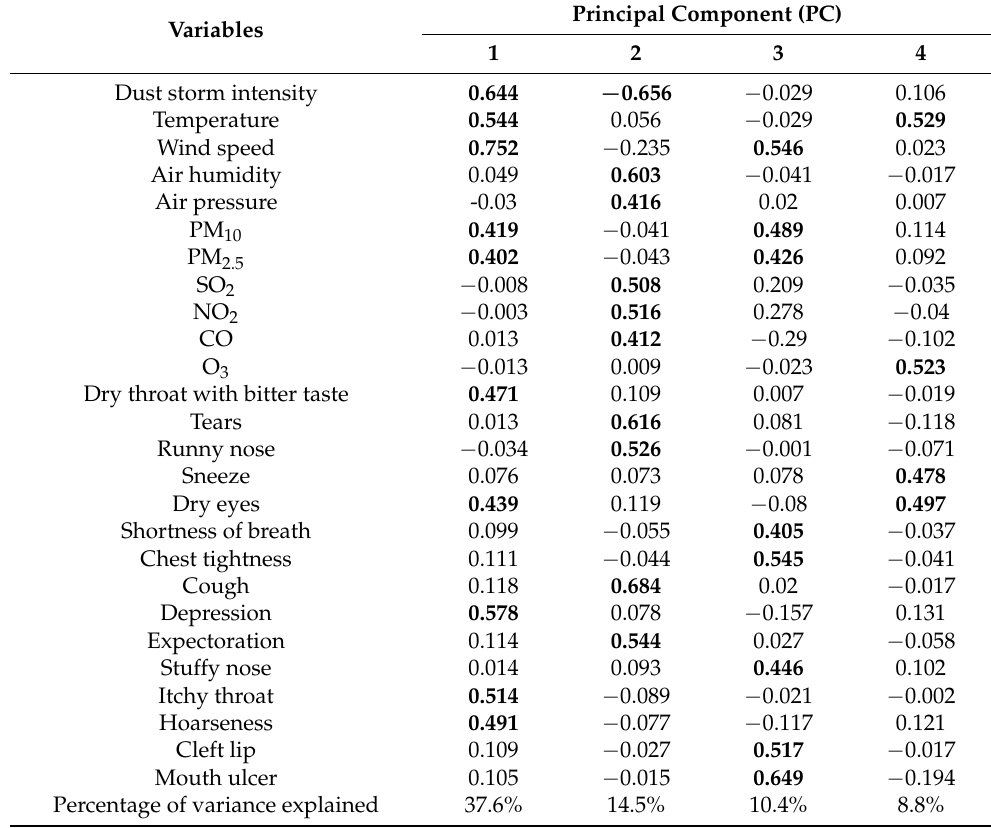
Table 1. Loadings of variables on the selected principal components (normalized variables with